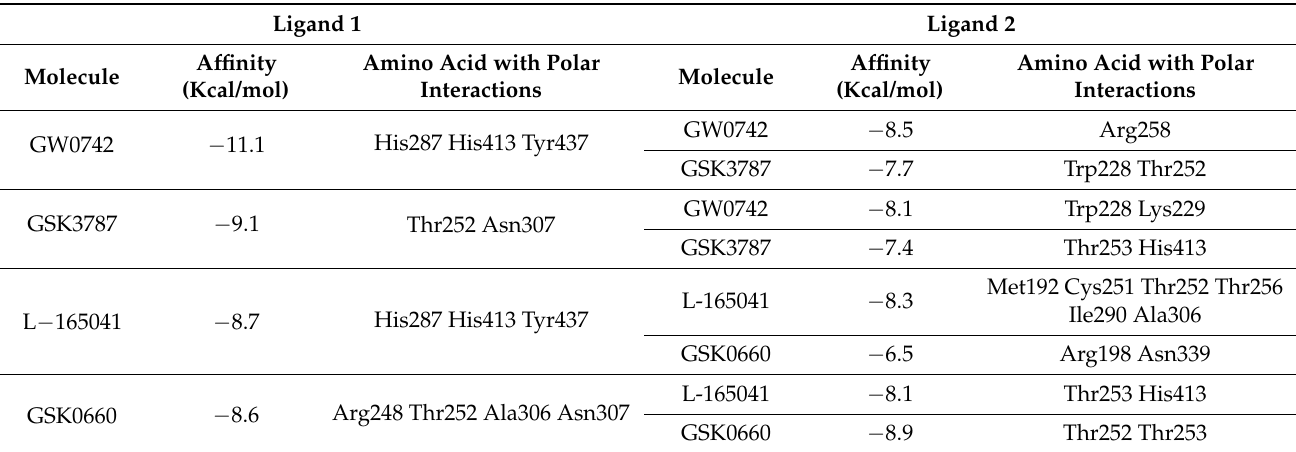
Table 2. Docking prediction of binding affinities and amino acids forming polar interactions with the PPAR β / δ ligands bound into the